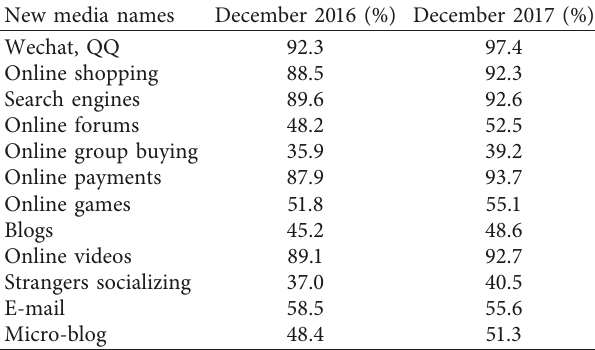
Table 4: New media applications for shoppers.